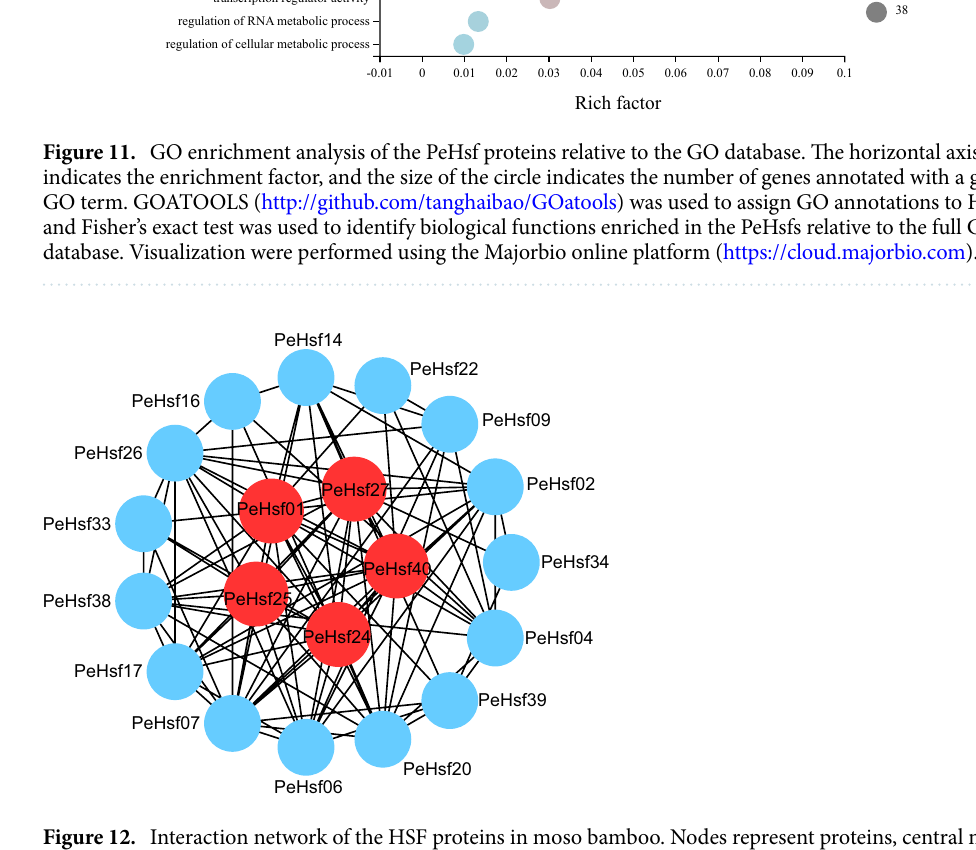
Figure 12. Interaction network of the HSF proteins in moso bamboo. Nodes represent proteins, central nodes are indicated in red, and black lines indicate interactions between nodes. Cytoscape (V3.7.1) (https:// cytos cape. org/) was used to visualize the resulting